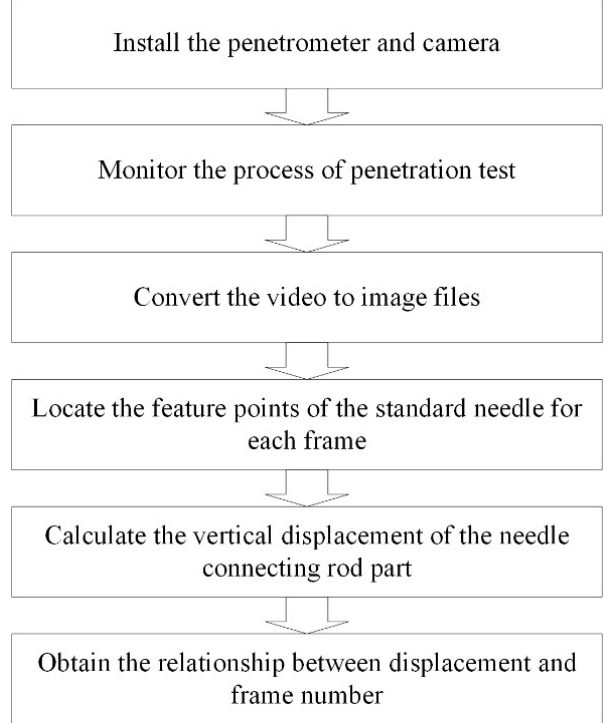
Figure 4. The image processing.